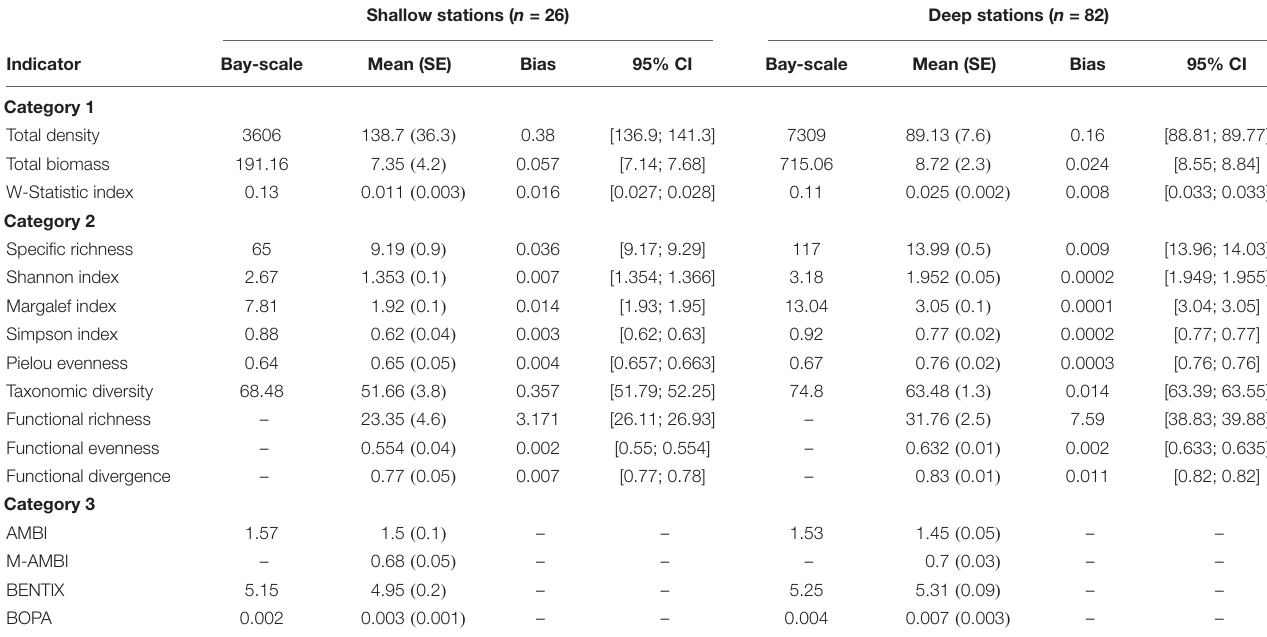
TABLE 3 | Values of the mean and standard error (SE) for each indicator, the difference between bootstrapped mean and the true mean (bias) and the 95% confidence interval (CI), for shallow and deep stations. Shallow stations ( n = 26) Deep stations ( n =